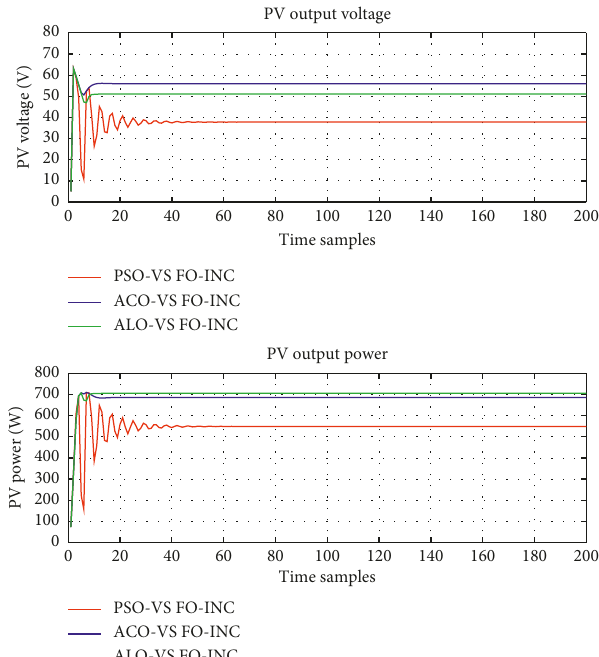
Figure 14: Optimization of variable FO-INC output response.